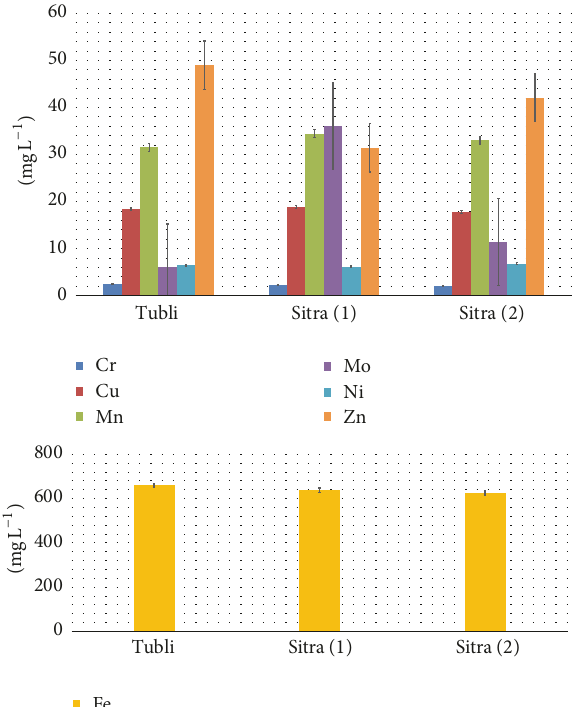
Figure 2: Heavy metals concentrations in the leaves of gray mangrove in the study sites (mgL −1